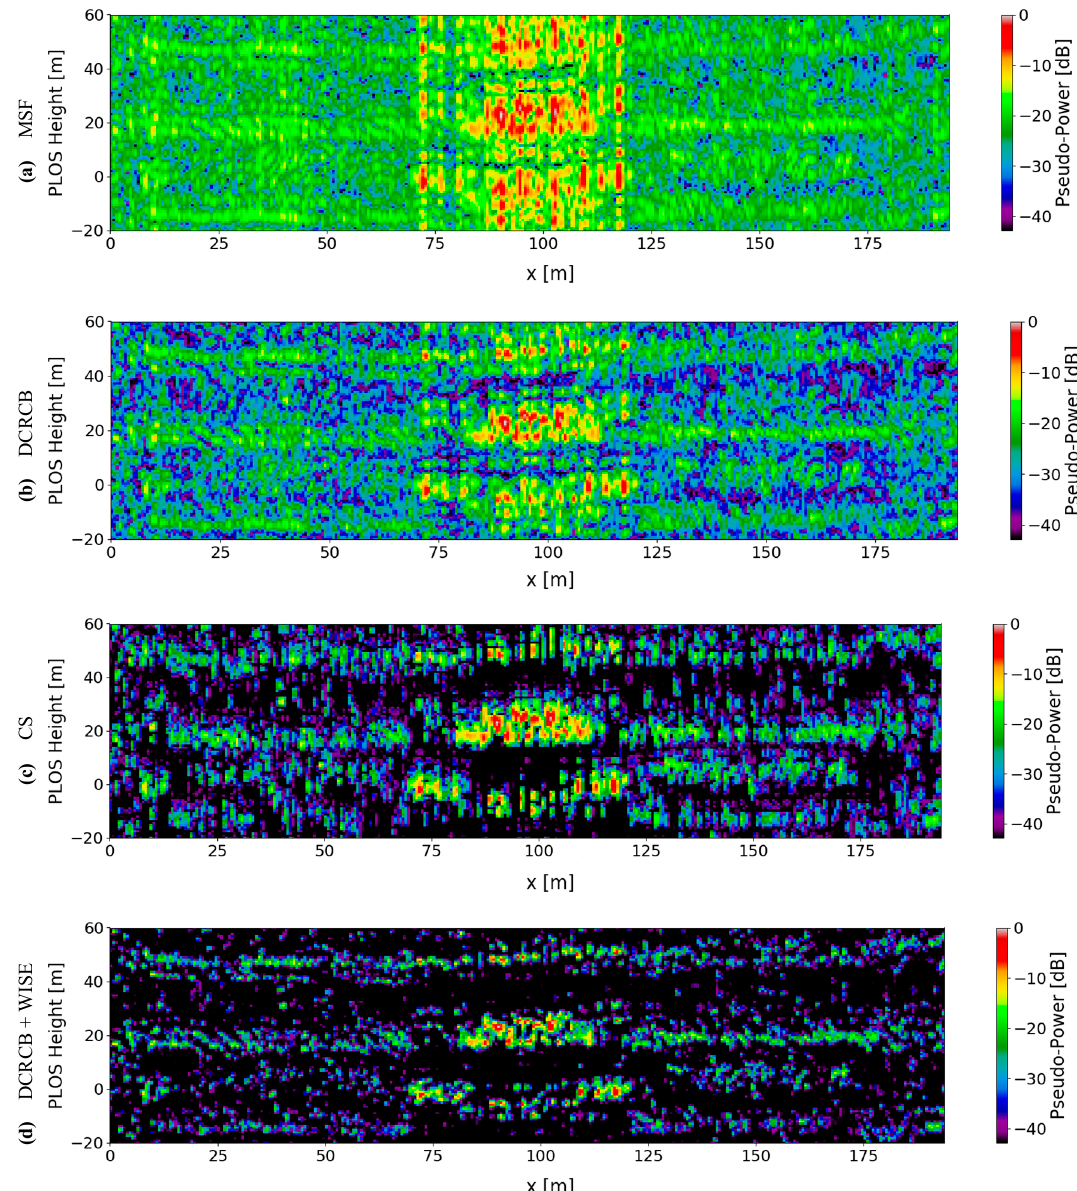
Figure 17. VV tomograms retrieved from the area depicted by the red line crossing the ROI specified in Figure 5. We perform focusing using ( a ) MSF, ( b ) DCRCB, ( c ) CS and ( d ) DCRCB + WISE. We refer to the single-look case. All tomograms are normalized with respect to the (pseudo) power recovered by MSF.